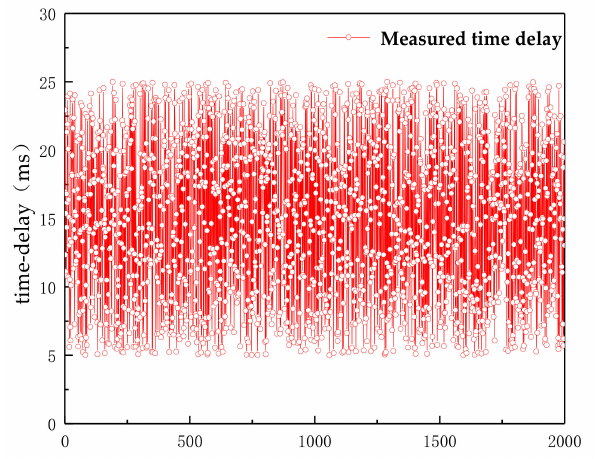
Figure 7. Measured time-delay sequence.